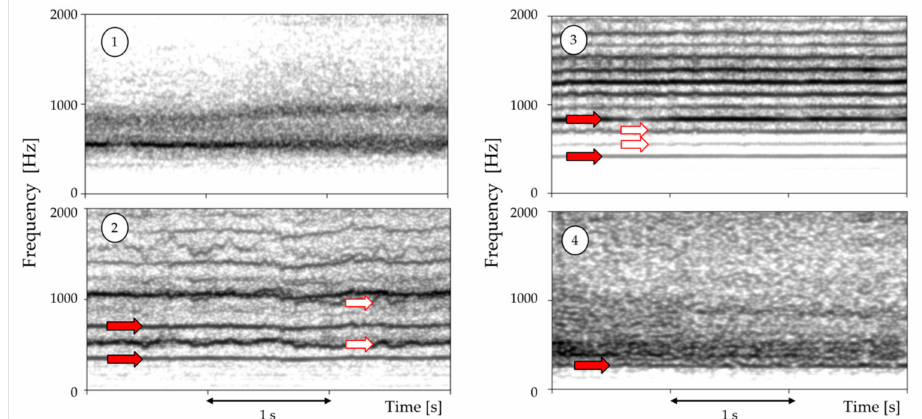
Figure 19. Spectrograms of different intentional voice distortions displayed by Praat software. Four examples are presented: ( 1 ) irregular aperiodic phonation; ( 2 ) biphonation; ( 3 ) subharmonic phona- tion with a predominance of harmonic components; ( 4 ) subharmonic phonation with a predominance of noise components (adapted from [59] with authors’ permission).